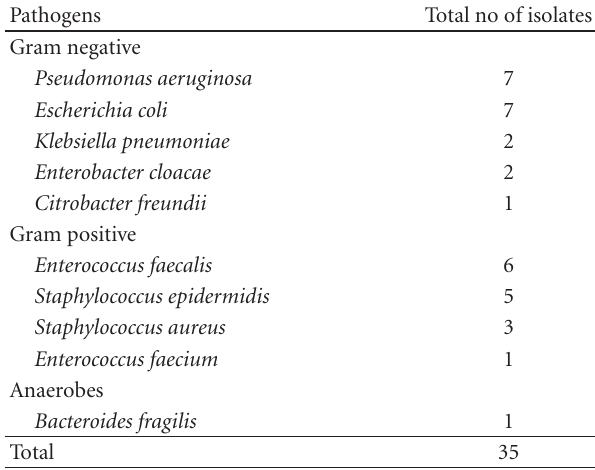
Table 4: Microorganisms isolated from 29 SSTIs